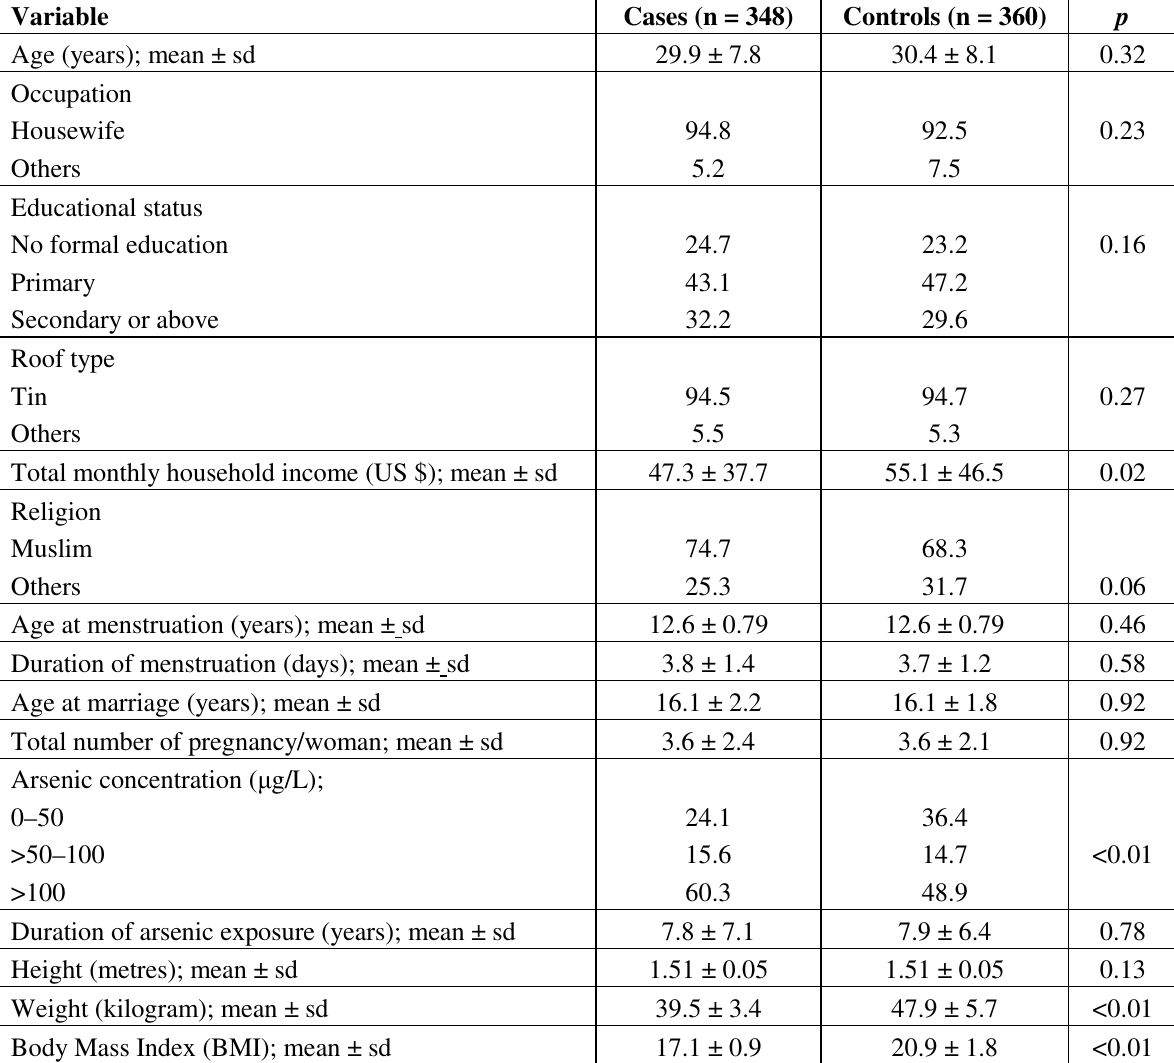
Table 1. Baseline characteristics of the cases and controls